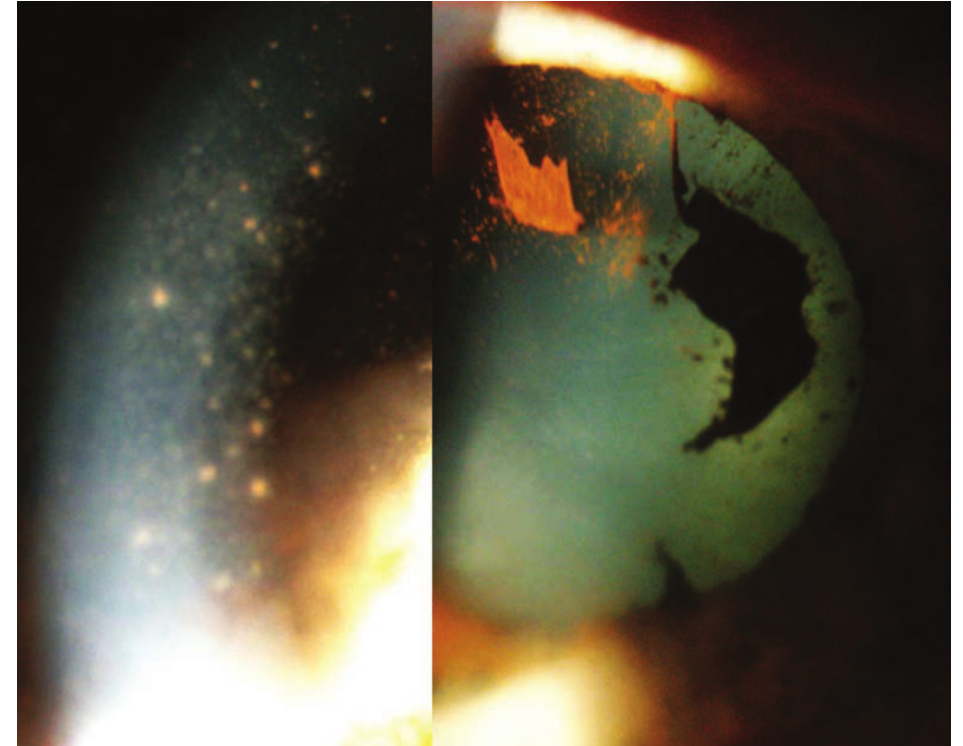
Figure 4. Massive mutton-fat KPs deposition on the endothelium in the right eye (left picture) after discontinuation of corticosteroid drops and posterior ruptured synechiae (right picture), incompatible with Fuchs’ uveitis.